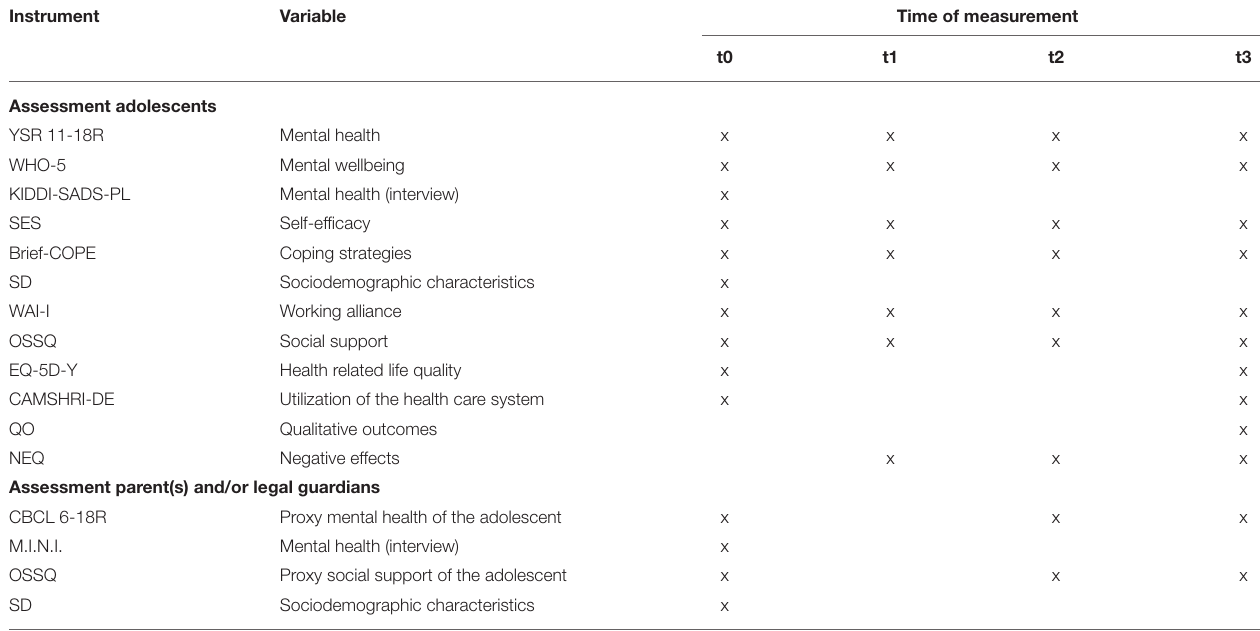
TABLE 2 | Overview